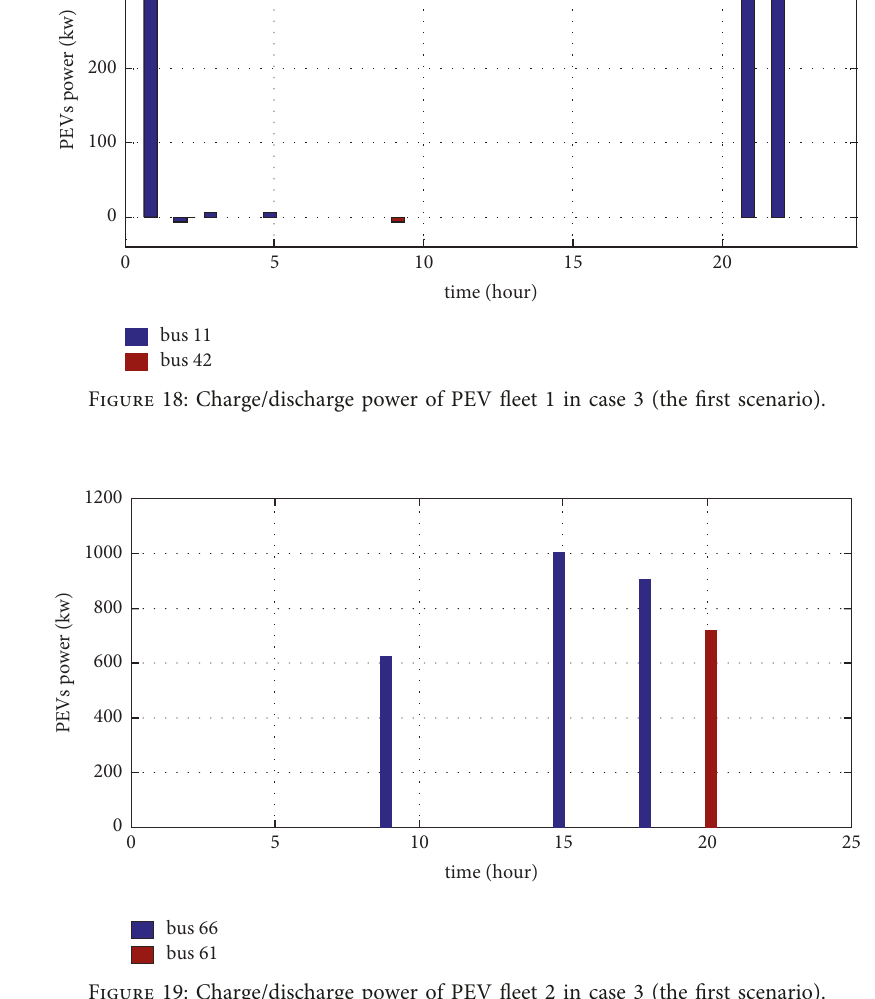
Figure 19: Charge/discharge power of PEV fleet 2 in case 3 (the first scenario).